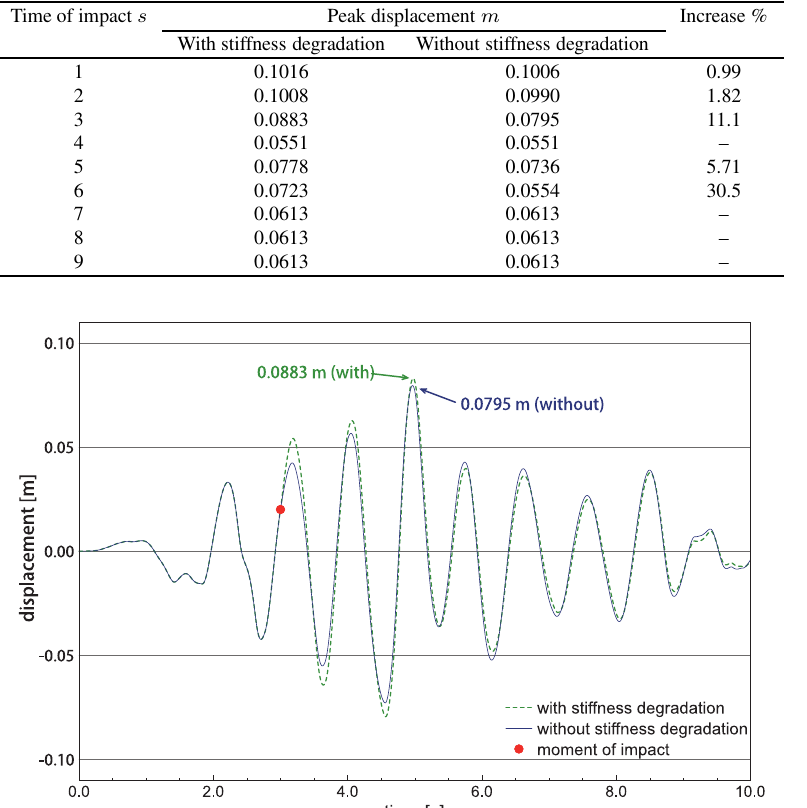
Table 1 Peak displacement values under the El Centro earthquake for different cases of impact times